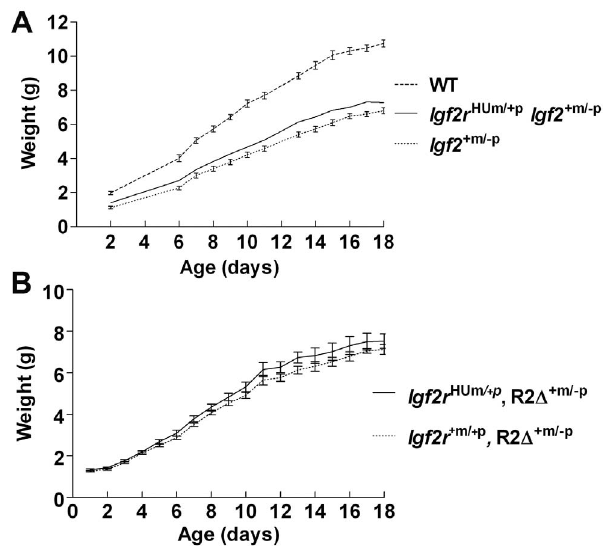
Figure 4. Rescue of Igf2r + m/HUp maternal transmission growth phenotype by loss of function of Igf2 and gain of function of Igf2r. ( A ) Maternal transmission to generate Igf2r HUm/ + p was combined with paternal transmission of the paternal null allele of Igf2 + m/ 2 p to generate combined heterozygotes ( Igf2r HUm/ + p , Igf2 + m/ 2 p ). Post-natal growth curves show that maternal transmission of the maternal allele did not alter growth rates when lethality was rescued by loss of Igf2 (Table 1). ( B ) Lethality of Igf2r HUm/ + p was rescued by paternal expression of Igf2r murine allele ( R2 D + m/ 2 p , see Table 1) and subsequent post-natal growth kinetics appeared similar.